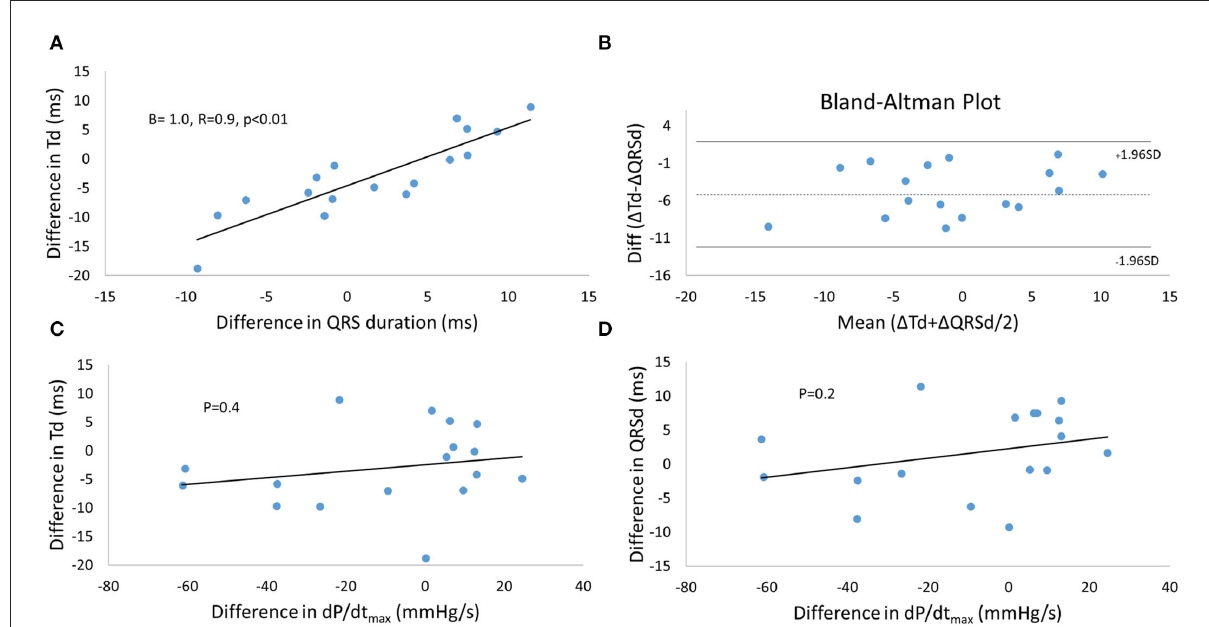
FIGURE4 Agreement between mechanical and electrical measures during resynchronization with different modes of pacing and electrode configurations. (A) The relationship between the difference in Td and QRSd from the reference (STANDARD*MPP*POST, see Figure 3) as a result of resynchronization, and the Bland-Altman Plot (B) to demonstrate the agreement between the measurements. Linear relationships between the difference in Td (C) or the difference in QRSd (D) and the difference in dP/dt max were not found. Td, time-to-peak dP/dt; dP/dt, first order derivative of